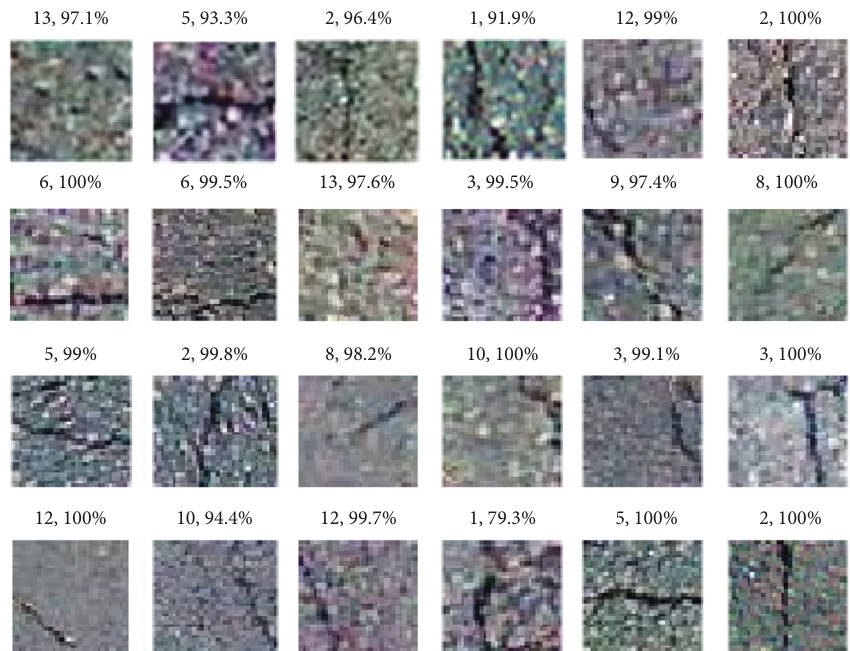
Figure 10: 24 randomly selected tiles from the test set. Category and its confidence are available on top of each tile.